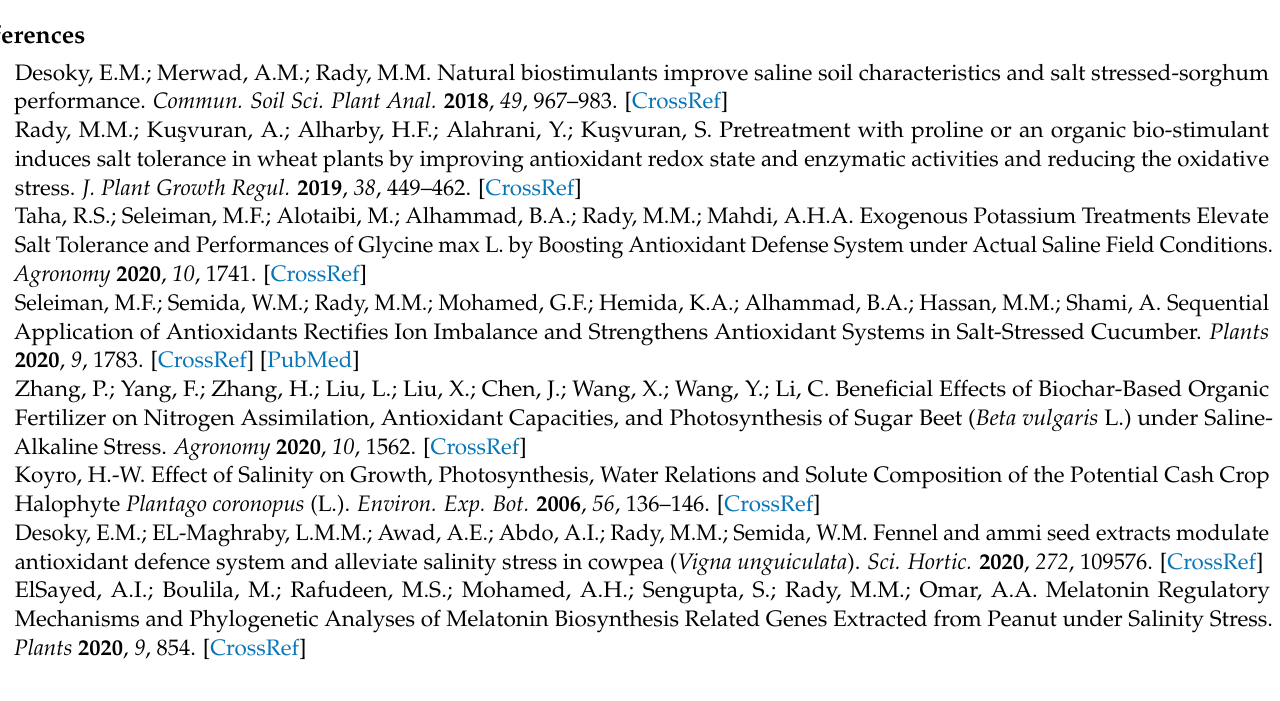
R-SUE (kg root kg S − 1 ) of sugar beet as affected by the interactions of sowing dates (d) and sulphure (S), in 2018/2019 season (Mean ± SE) under soil salinity (ECe = 8.96 dS m − 1 ) conditions, Figure S17: R-KUE (kg root kg K − 1 ) and R-SUE (kg root kg S − 1 ) of sugar beet as affected by the interactions of sowing dates (d) and sulphure (S), in 2019/2020 season (Mean ± SE) under soil salinity (ECe = 8.96 dS m − 1 ) conditions, Figure S18: R-KUE (kg root kg K − 1 ) and R-SUE (kg root kg S − 1 ) of sugar beet as affected by the interactions of potassium (K) and sulphur (S), in 2018/2019 season (Mean ± SE) under soil salinity (ECe = 8.96 dS m − 1 ) conditions, Figure S19: R-KUE (kg root kg K − 1 ) and R-SUE (kg root kg S − 1 ) of sugar beet as affected by the interactions of potassium (K) and sulphur (S), in 2019/2020 season (Mean ± SE) under soil salinity (ECe = 8.96 dS m − 1 ) conditions, Figure S20: Root yield (Mg ha − 1 ) and pure sugar yield (Mg ha − 1 ) of sugar beet as affected by the interactions of sowing date (D), potassium (K) and sulphur (S), in 2018/2019 season (Mean ± SE) under soil salinity (ECe = 8.96 dS m − 1 ) conditions, Figure S21: Root yield (Mg ha − 1 ) and pure sugar yield (Mg ha − 1 ) of sugar beet as affected by the interactions of sowing date (D), potassium (K) and sulphur (S), in 2019/2020 season (Mean ± SE) under soil salinity (ECe = 8.96 dS m − 1 )